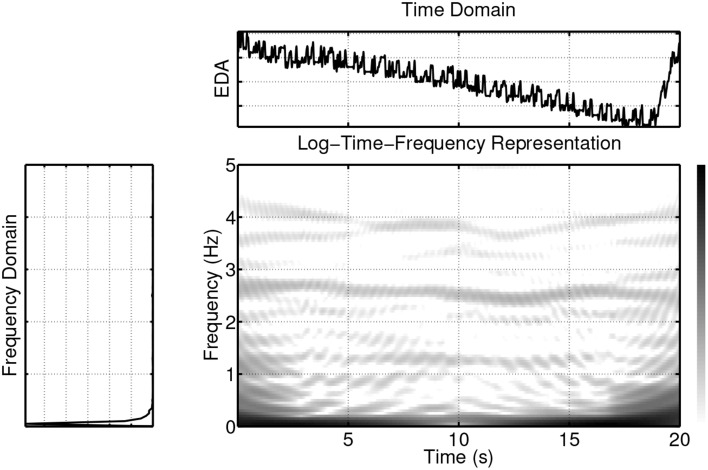
Element-wise logarithm of the time-frequency distribution of the EDA signal depicted in Figure 4, second panel. For this example, the pulse frequency region and its harmonics become clearly visible in the EDA signal.